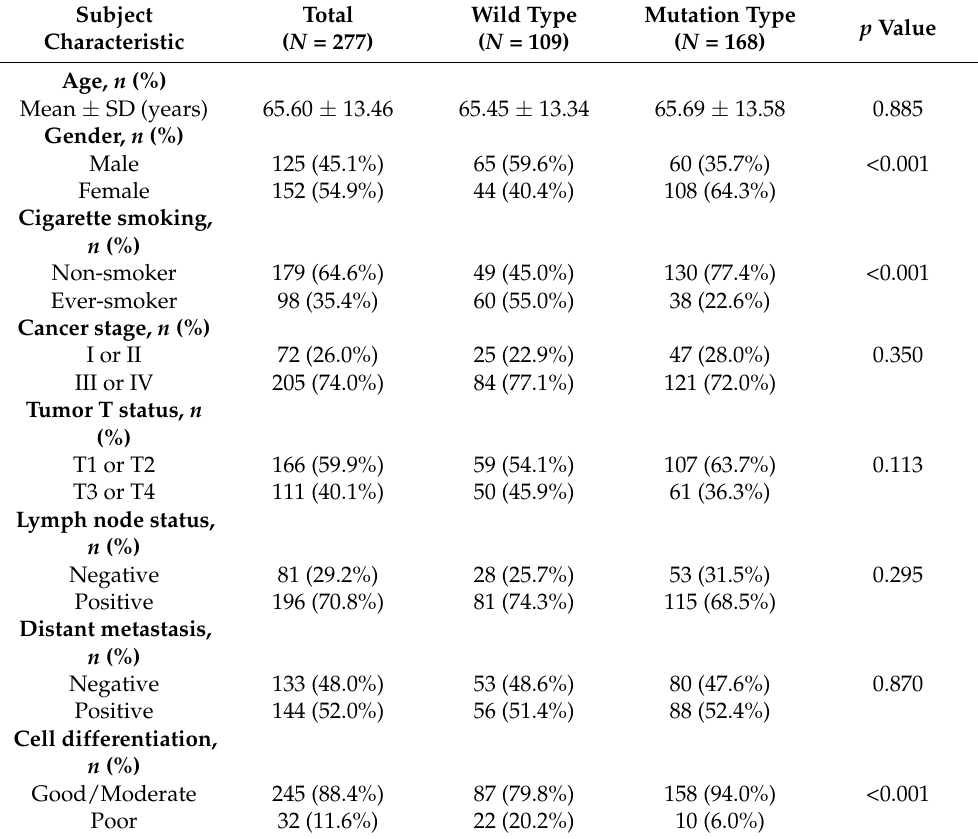
Table 1. Clinical characteristics of lung adenocarcinoma patients with the wild type or mutation type of the epidermal growth factor receptor